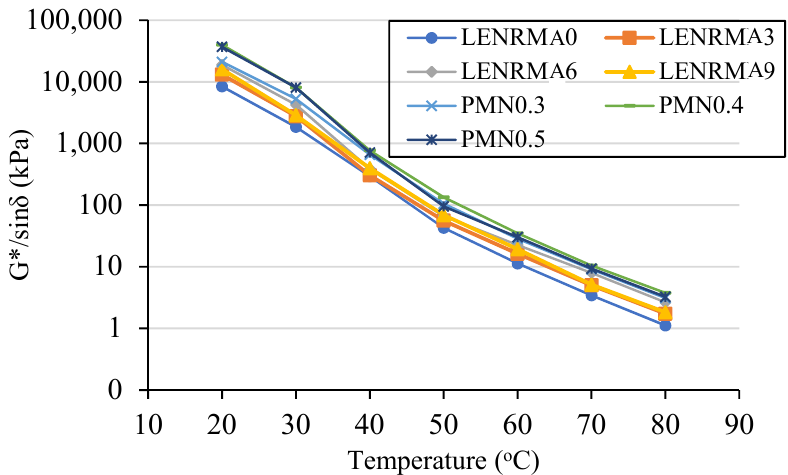
Figure 14. Effect of temperature on the rutting parameters (G*/sin δ ).